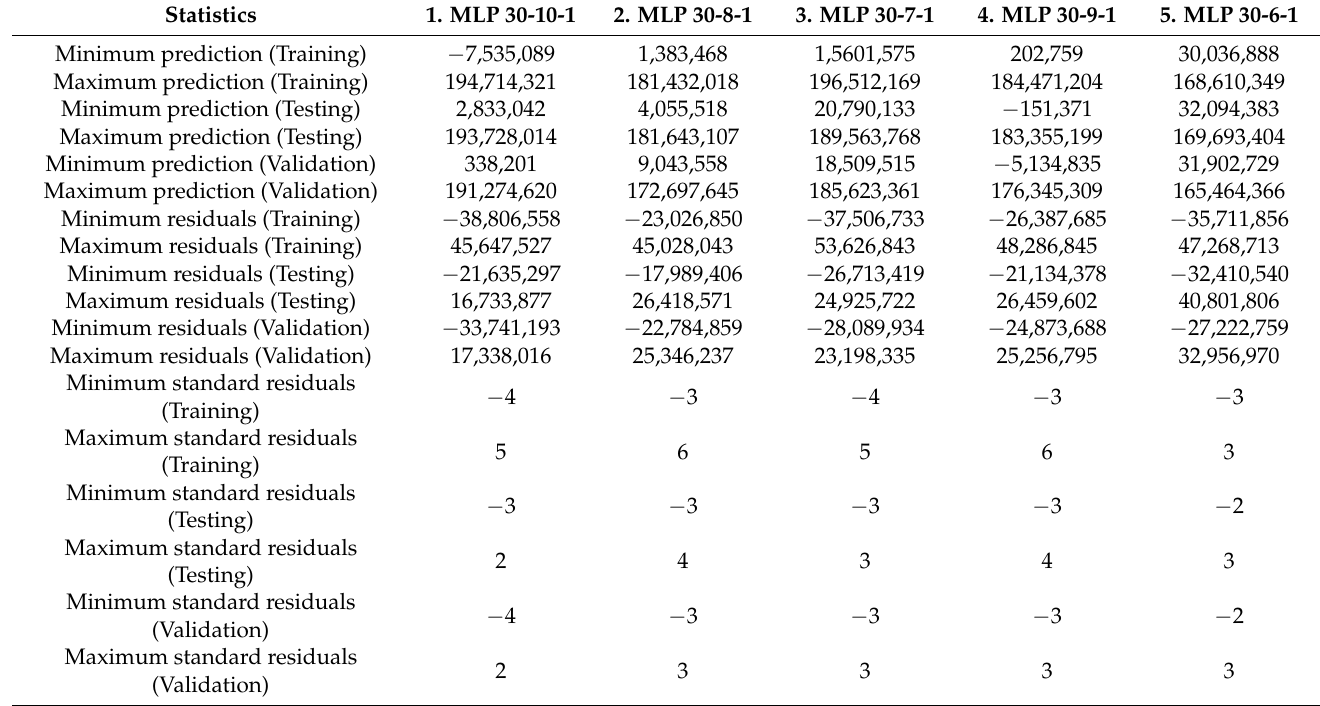
Table A4. Basic statistics of equalized time series—10-month